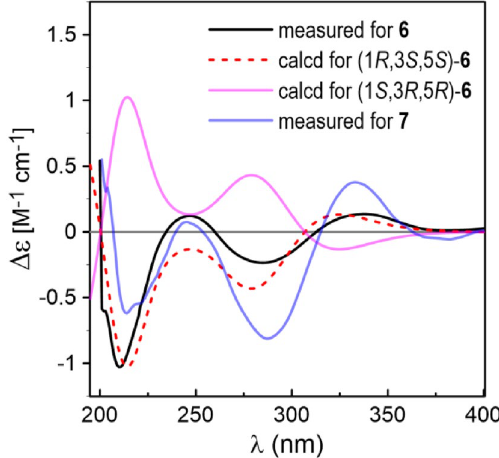
Fig. 6 Comparison between the ECD spectra measured for 8 and PBE0/TZVP/PCM calculated for four possible stereoisomers of 8 (σ = 0.38, shift = −2